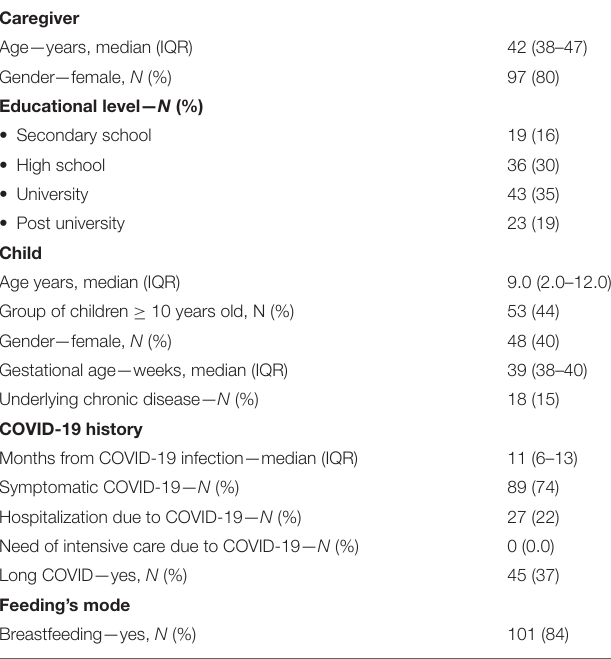
TABLE 1 | Baseline characteristics of caregivers and children (data are given as median and interquartile range or absolute frequency and percentage). Caregiver